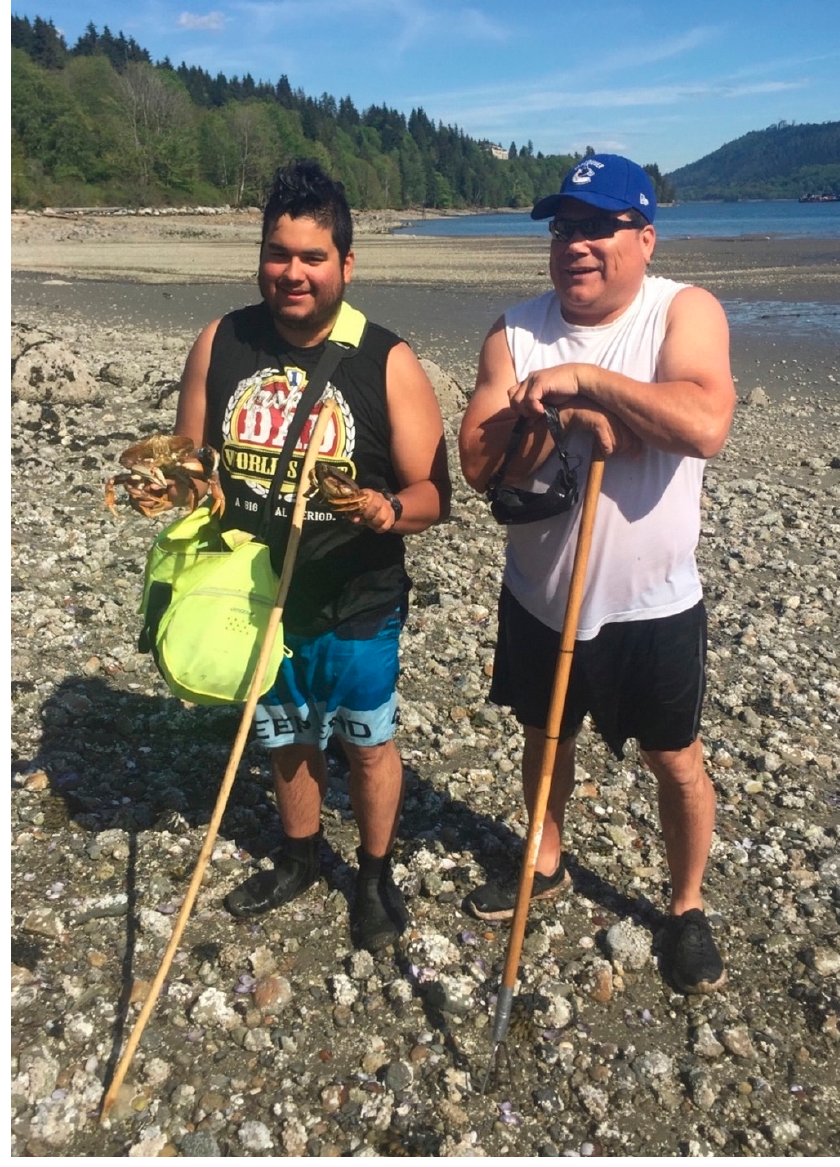
Figure 5. Crab fishers (Photo Credit: Jerry Spiegel).